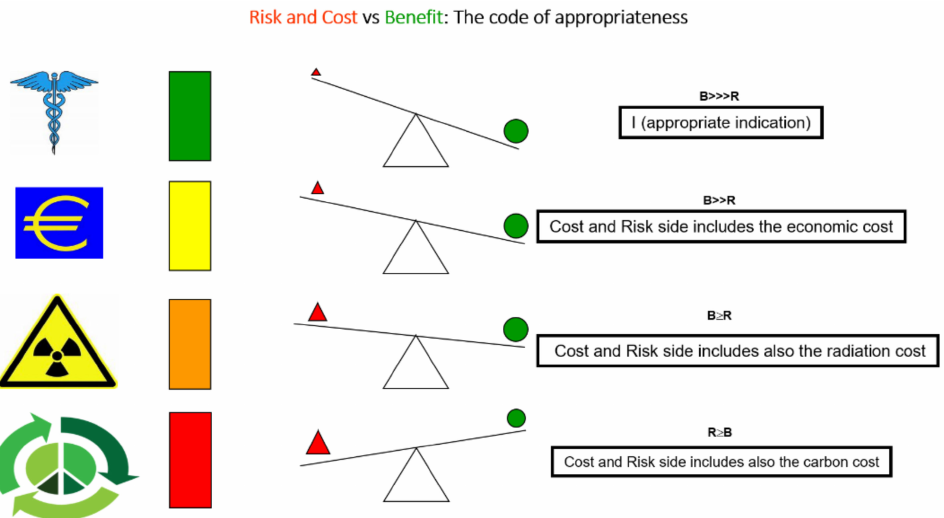
Figure 3. The cost-benefit assessment in medical imaging (first row) includes the medical benefit (such as diagnostic accuracy) balanced with the acute risks, such as the occurrence of myocardial infarction during stress. Over the last two decades, a more comprehensive assessment was introduced. Integrating on the cost side is the economic cost (second row), the radiological risk linearly related to the long-term risk of cancer (third row), and now, the environmental or carbon cost related to the detrimental effect on the planet (last